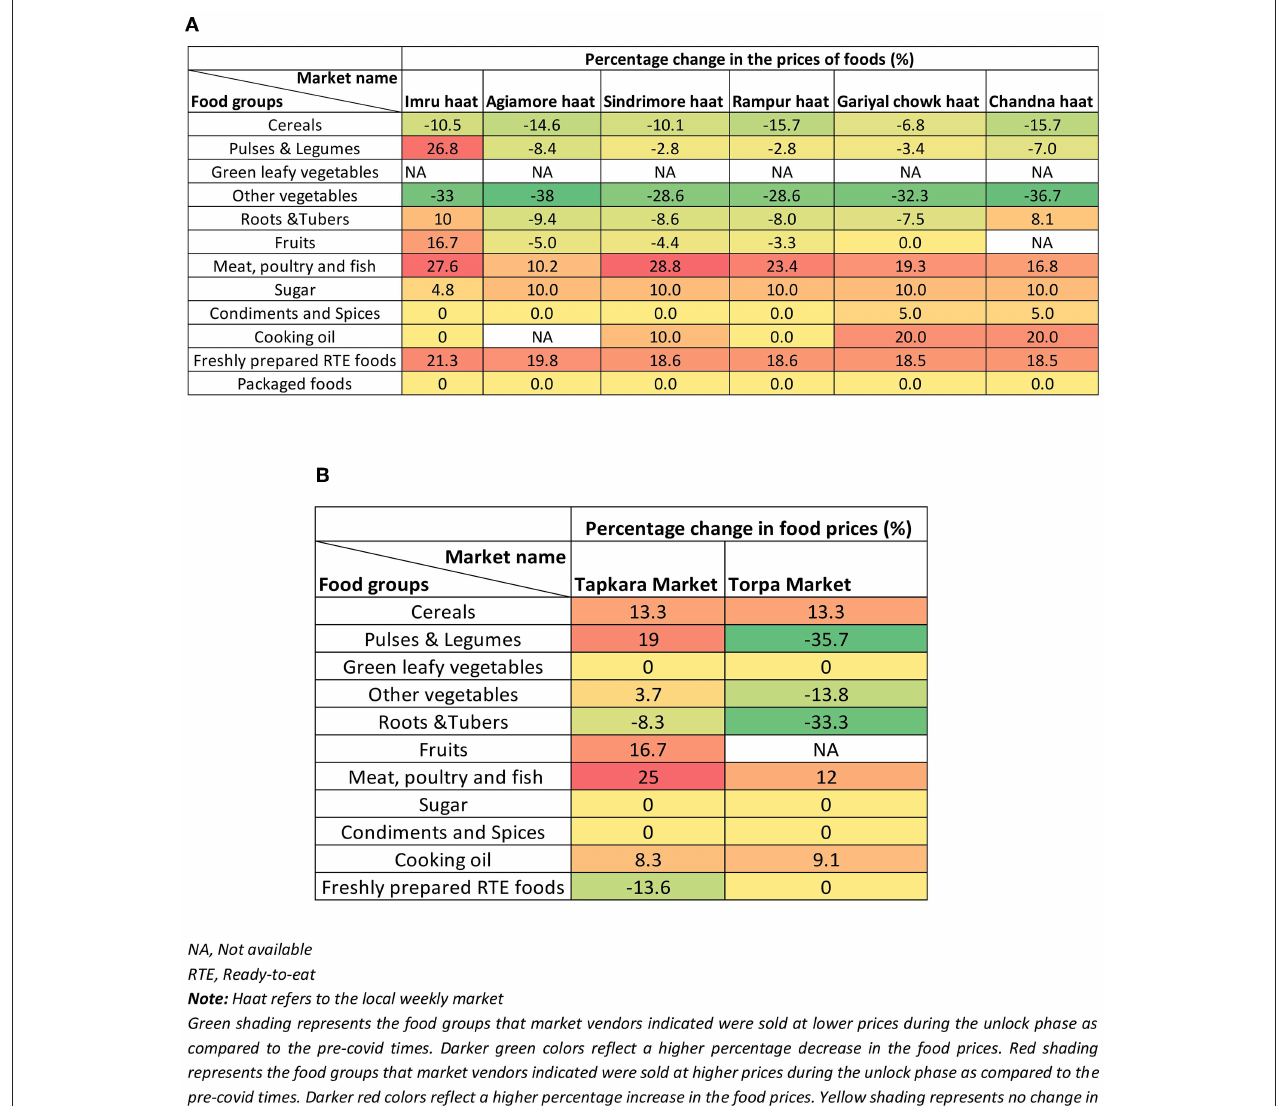
FIGURE 11 | Impact of COVID-19 pandemic on the retail prices of the food groups in the informal markets in indigenous communities of Jharkhand, India. (A) Impact of COVID-19 pandemic on retail prices of food groups in the informal markets of Godda district, Jharkhand, India, catering to Santhal and Sauria Paharia communities. (B) Impact of COVID-19 pandemic on retail prices of food groups in the informal markets of Khunti district, Jharkhand, India, catering to Munda